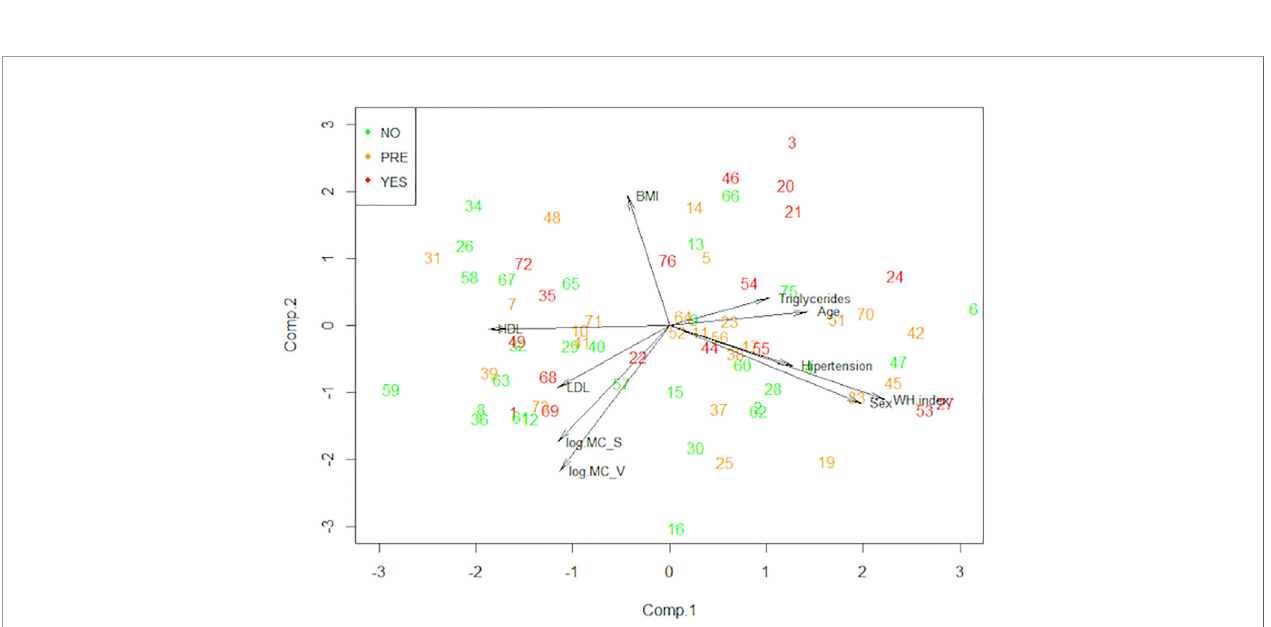
FIGURE 6 | Differences in mast cells per gram of tissue between subcutaneous and omental white adipose tissue in patients with type 2 diabetes. The data comes from the big cohort (n = 100). MC (mast cells), s-WAT (subcutaneous white adipose tissue), o-WAT (omental white adipose tissue), T2D (type 2 diabetes), “ ns ” (p-value >